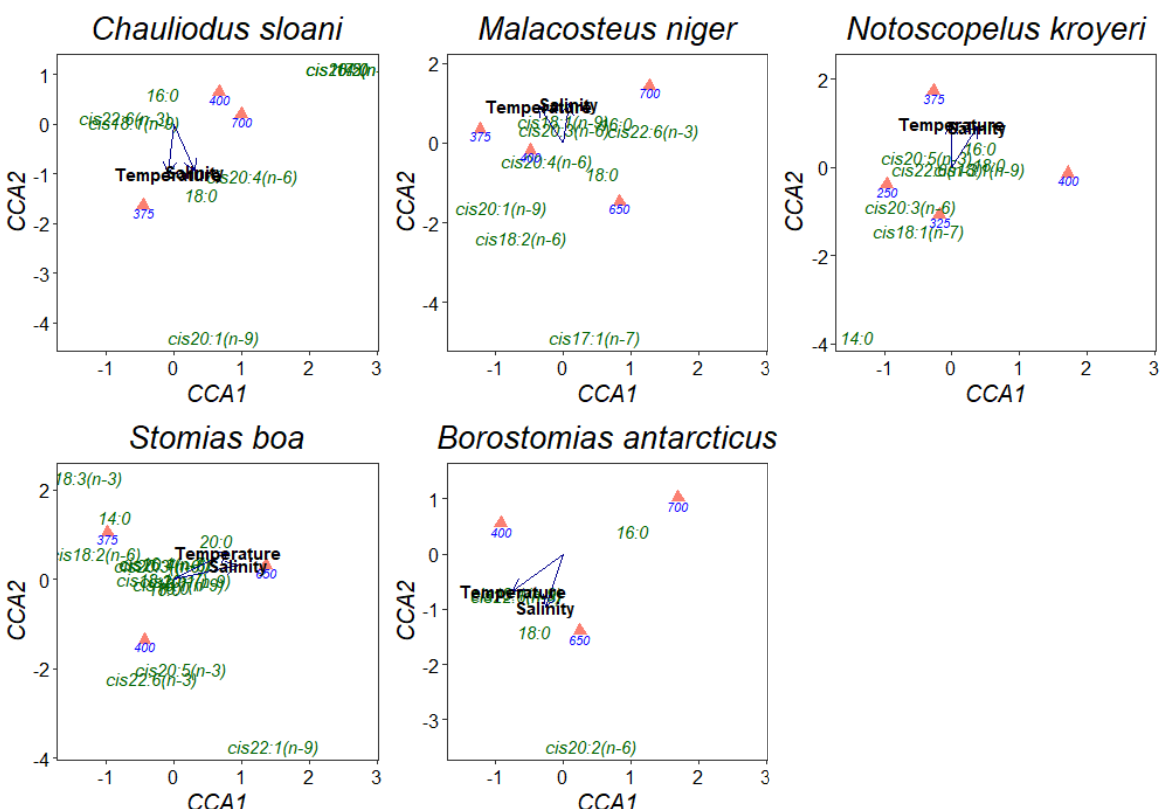
Figure 6. Canonical correspondence analysis (CCA) ordination of the effects of abiotic environmental impacts (temperature and salinity) on individual fatty acids in phospholipids in muscle tissues of mesopelagic fishes ( Notoscopelus kroyeri , Symbolophorus veranyi , Chauliodus sloani , Stomias boa , Malacosteus niger , and Borostomias antarcticus ) across the depth gradient in the Irminger Sea (North Atlantic).